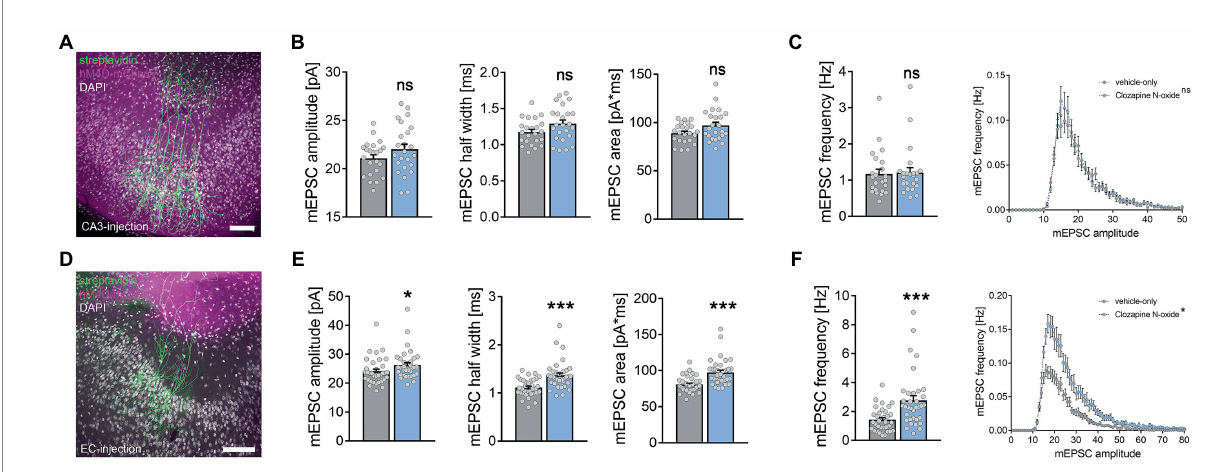
FIGURE 6 Homeostatic synaptic plasticity in CA1 neurons is specifically induced by chemogenetic silencing of the perforant path. (A) Example of recorded and posthoc stained CA1 cells in tissue cultures where viral injection of AAV2-hSyn-hM4D-mCherry was performed in the CA3 region to silence the Schaffer collateral pathway. Scale bar, 100 μ m. (B,C) Chemogenetic silencing of the Schaffer collateral pathway did not lead to an increase in mEPSC amplitude, area or half width (B) . Furthermore, mEPSC frequency and amplitude/frequency analysis reveal no significant differences ( C , n control = 23 cells, n CNO = 24 cells, Mann–Whitney test for column statistics and RM-two-way ANOVA followed by Sidak’s multiple comparisons test for XY-plot analysis). (D) Example of recorded and posthoc stained CA1 cells in tissue cultures where viral injection of AAV2-hSyn-hM4D-mCherry was performed in the entorhinal cortex (EC) to silence the perforant path. Scale bar 100 μ m. (E,F) Silencing of the perforant path led to a significant increase in mEPSC amplitude, area and half width (E) . In line with that, mEPSC frequency was robustly increased and amplitude/frequency analysis revealed significant differences ( F , n control = 34 cells, n CNO = 35 cells, Mann–Whitney test for column statistics and RM-two-way ANOVA followed by Sidak’s multiple comparisons test for XY-plot analysis). Individual data points are indicated by colored dots. Values represent mean ± s.e.m. (* p < 0.05, *** p < 0.001, ns - non significant difference).